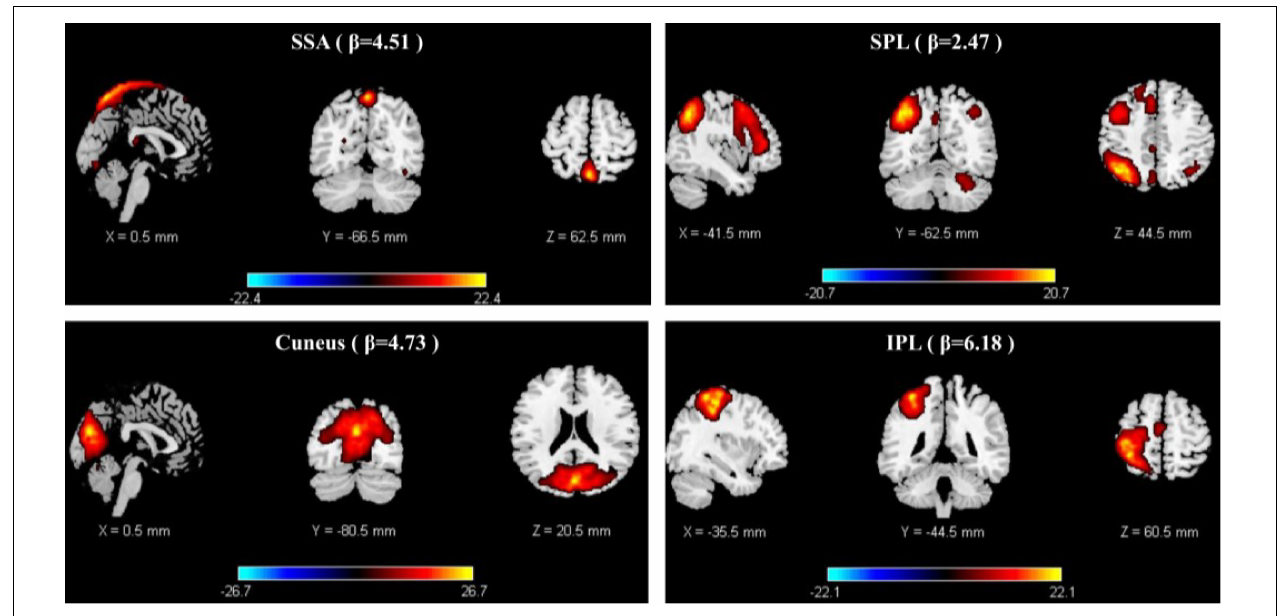
FIGURE 5 | The stronger activation of ICA in decreasing music than increasing